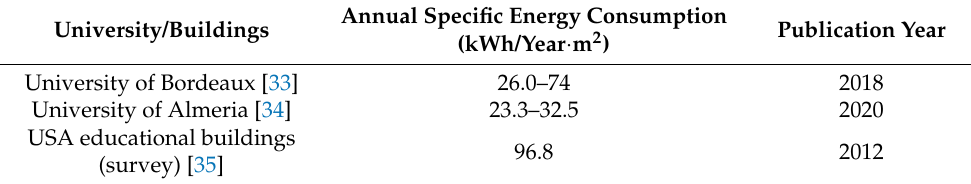
Table 13. Annual speci fi c energy consumptions reported for administrative University buildings.